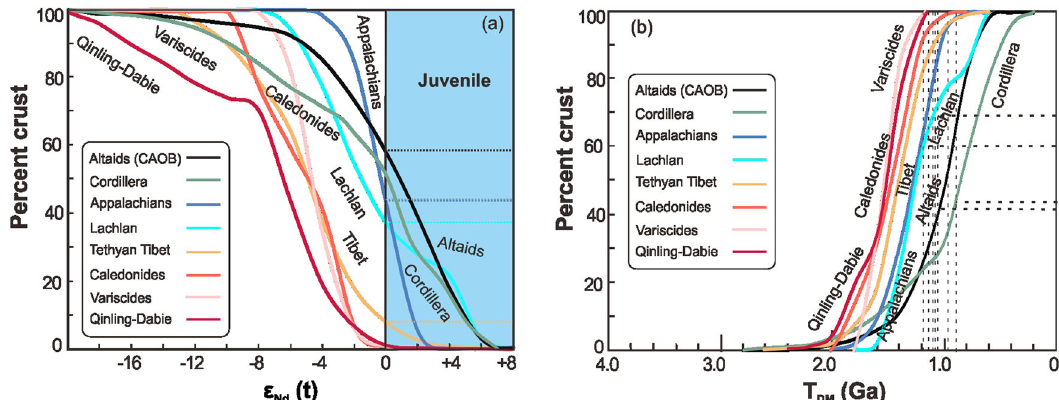
Fig. 4 Crustal growth curves for the eight orogens. The curves show a the percentage areas of crust produced per two ε Nd (t) value intervals and b per 200 Myr T DM2 interval. The percentages are drawn from the areas of ε Nd (t) and T DM2 isotopic domains respectively (Fig. 3 and Supplementary Data 10). So, these crustal growth curves directly denote crustal growth, which is different from commonly used crustal growth curves made by cumulative frequency plots of global isotopic datasets 29 – 34 . The vertical dashed lines (b) represent T DM2 corresponding to ε Nd (t) = 0, and the dotted horizontal lines denote the percentages of the crust when ε Nd (t) = 0, the distinction between juvenile and evolved. Taking the Altaids for instance, ~58% of juvenile crust had been generated at ~1.0 Ga. The colors of the solid and dotted lines represent different orogens. Data are listed in Supplementary Data